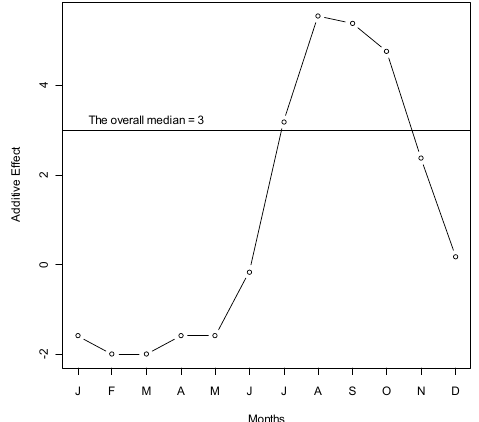
Figure 1. Median polish of the number of dengue cases over months during years 2005–2009 in Zone-5 of Dhaka City Corporation, Dhaka, Bangladesh. Y-axis represents the monthly additive effect of hospitalized dengue cases to the overall median in square root scale. X-axis represents the months. To get the median dengue cases in a specific month, add the overall median to the month’s effect and take the square. For example, the median number of dengue cases in June is (3 − 0) 2 = 9 cases (approximately).